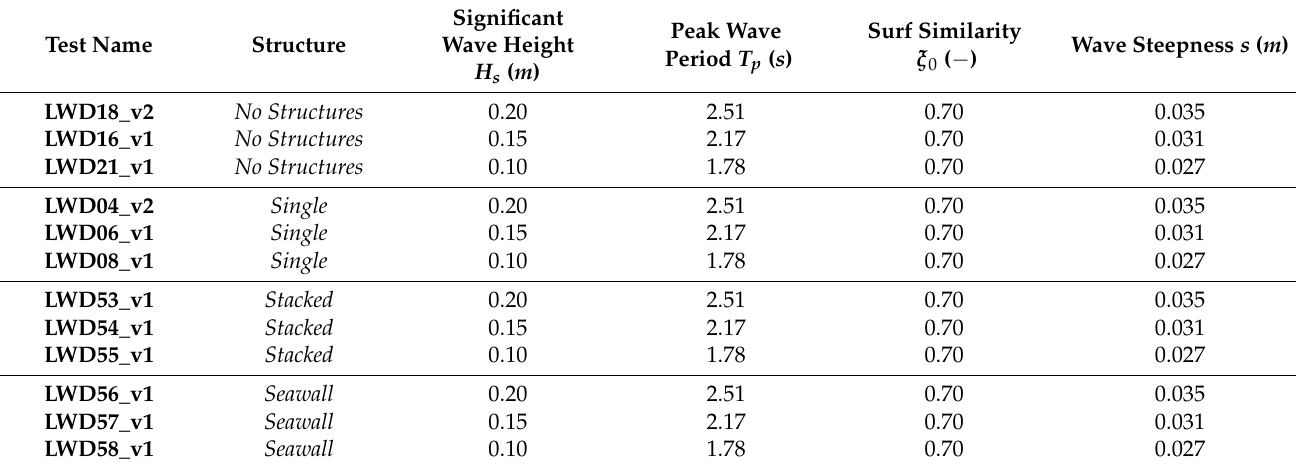
Table 1. Overview of test runs and associated parameters, used in this study.